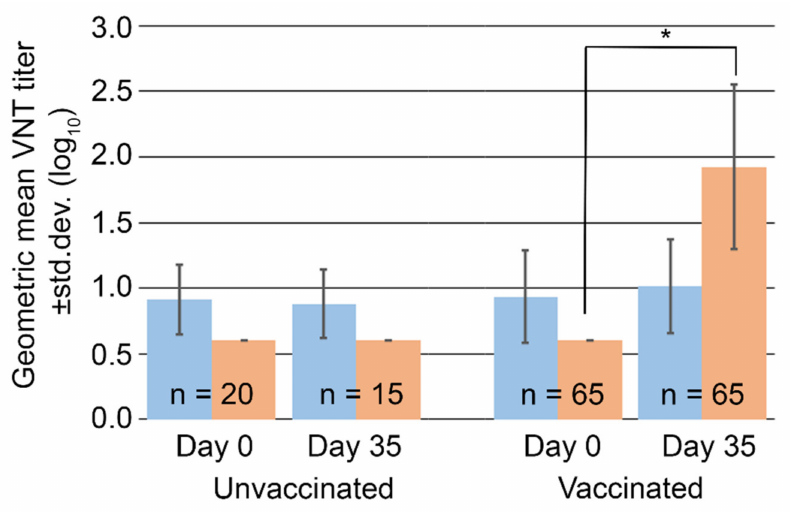
Figure 5. Mean virus neutralizing antibody titers (log 10 ) against SVA, blue, and FMDV, orange. No statistically significant differences in SVA titers between unvaccinated and FMD vaccinated swine are observed unlike neutralizing titers against FMD which increased in response to FMD vaccination. * represents p < 0.001 using a Student’s paired t